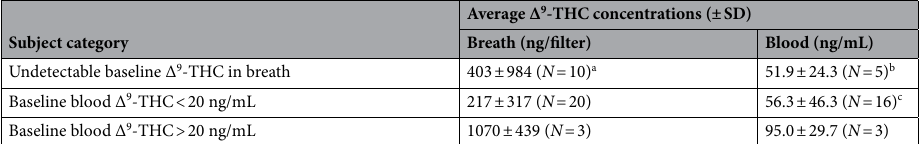
Table 4. Relationship between ∆ 9 -THC concentrations in exhaled breath and blood at peak impairment. a One outlier removed. b Six subjects were not sampled at peak impairment. c Four subjects were not sampled at peak